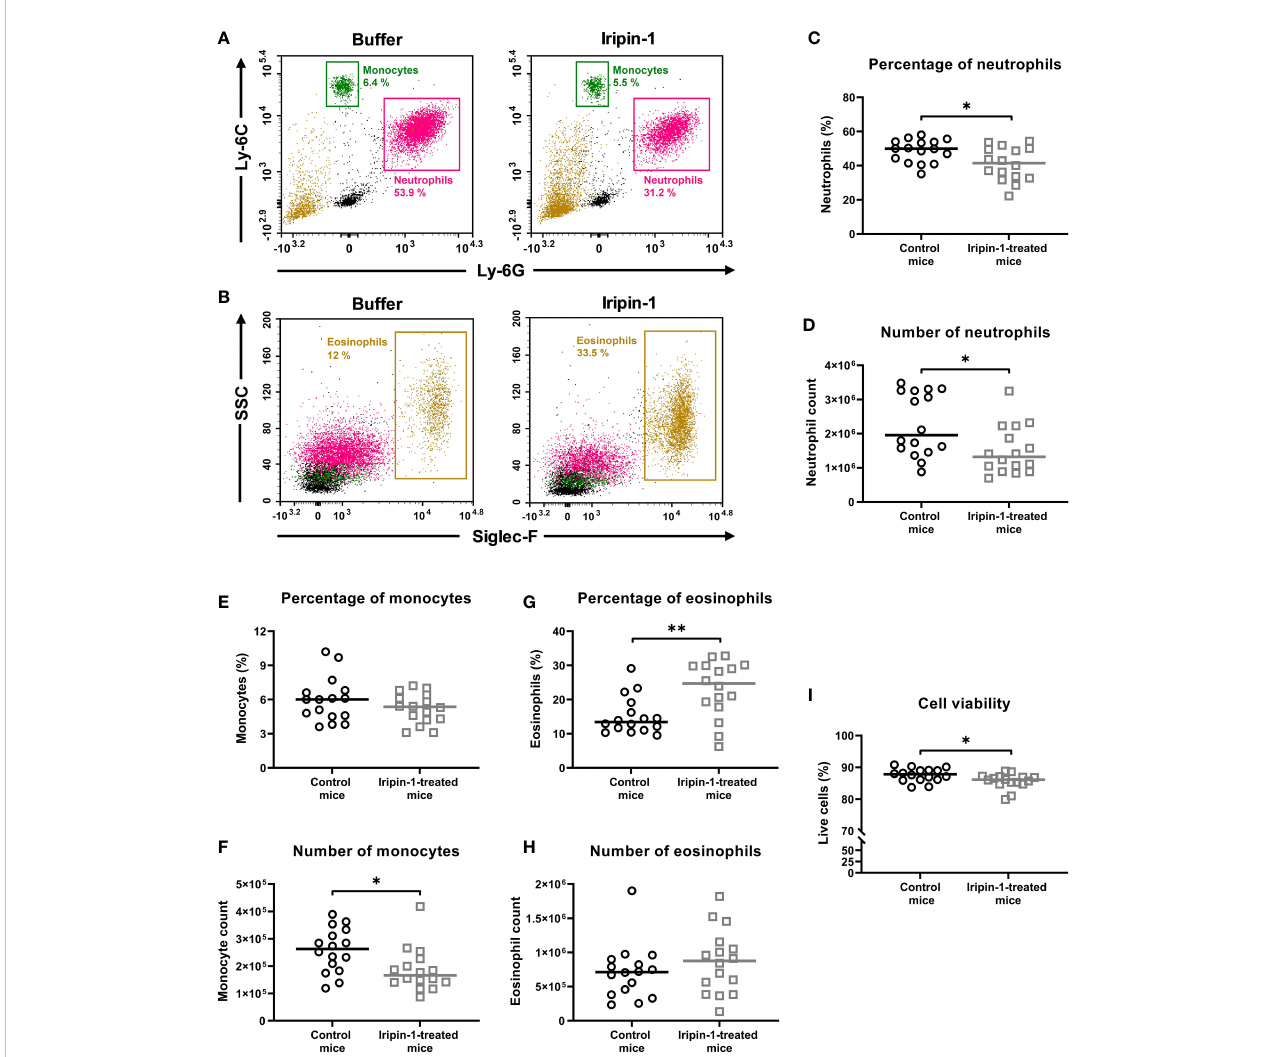
FIGURE 6 Iripin-1 inhibits the recruitment of neutrophils and monocytes and has no signi fi cant effect on the migration of eosinophils in the thioglycolate-induced peritonitis model. (A, B) Dot plots showing the percentage of (A) neutrophils (Ly-6G + Ly-6C + cells), monocytes (Ly-6C high cells), and (B) eosinophils (Siglec-F + cells) in the peritoneal cavities of mice injected with either control buffer and TGM or Iripin-1 and TGM. SSC, side scatter. (C, E, G, I) Mice were injected ip with Iripin-1 (2 mg/kg) or the corresponding amount of control buffer, and peritonitis was induced with ip injection of 200 m L 3% TGM. Cells obtained by peritoneal lavage 4 h after TGM administration were analyzed on a fl ow cytometer to determine the percentages of neutrophils (C) , monocytes (E) , and eosinophils (G) among all live cells, and the percentage of viable cells (I) among single cells. (D, F, H) Cells harvested by peritoneal lavage were also counted under a light microscope, and the combination of fl ow cytometry data with known cell numbers provided the information about the numbers of neutrophils (D) , monocytes (F) , and eosinophils (H) that migrated to in fl amed peritoneal cavities. In the graphs, each control mouse is represented by one black-lined circle, and each Iripin-1-treated mouse is represented by one grey-lined square. The black and grey horizontal lines mark the median values. Asterisks indicate statistically signi fi cant difference between the two groups (*p < 0.05, **p <